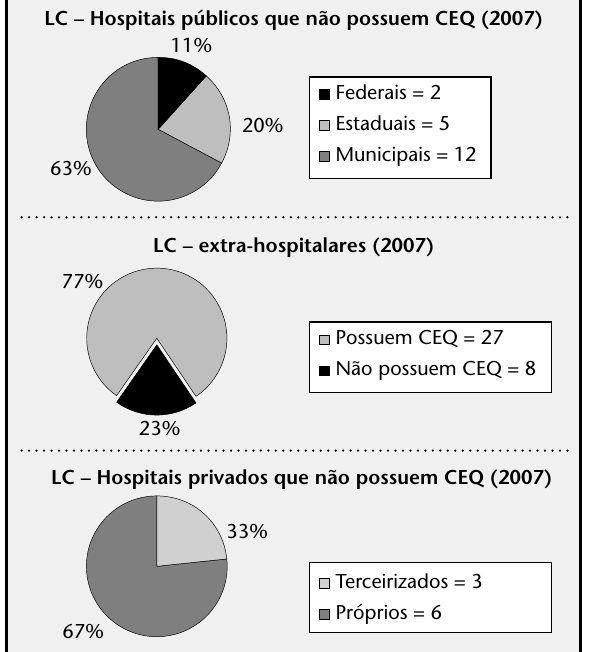
Figura 2 – Total de LCs (ano 2007) que não possuíam CEQ = 36 LC: laboratório clínico; CEQ: controle externo de qualidade.